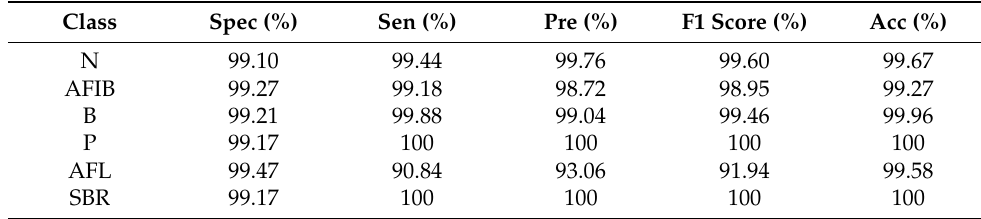
Table 5. Classification performance for ECG rhythms with similar characteristics.